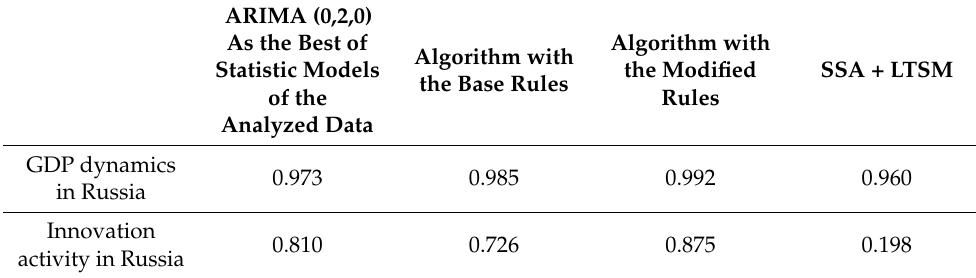
Table 1. The results of the model comparison based on R 2